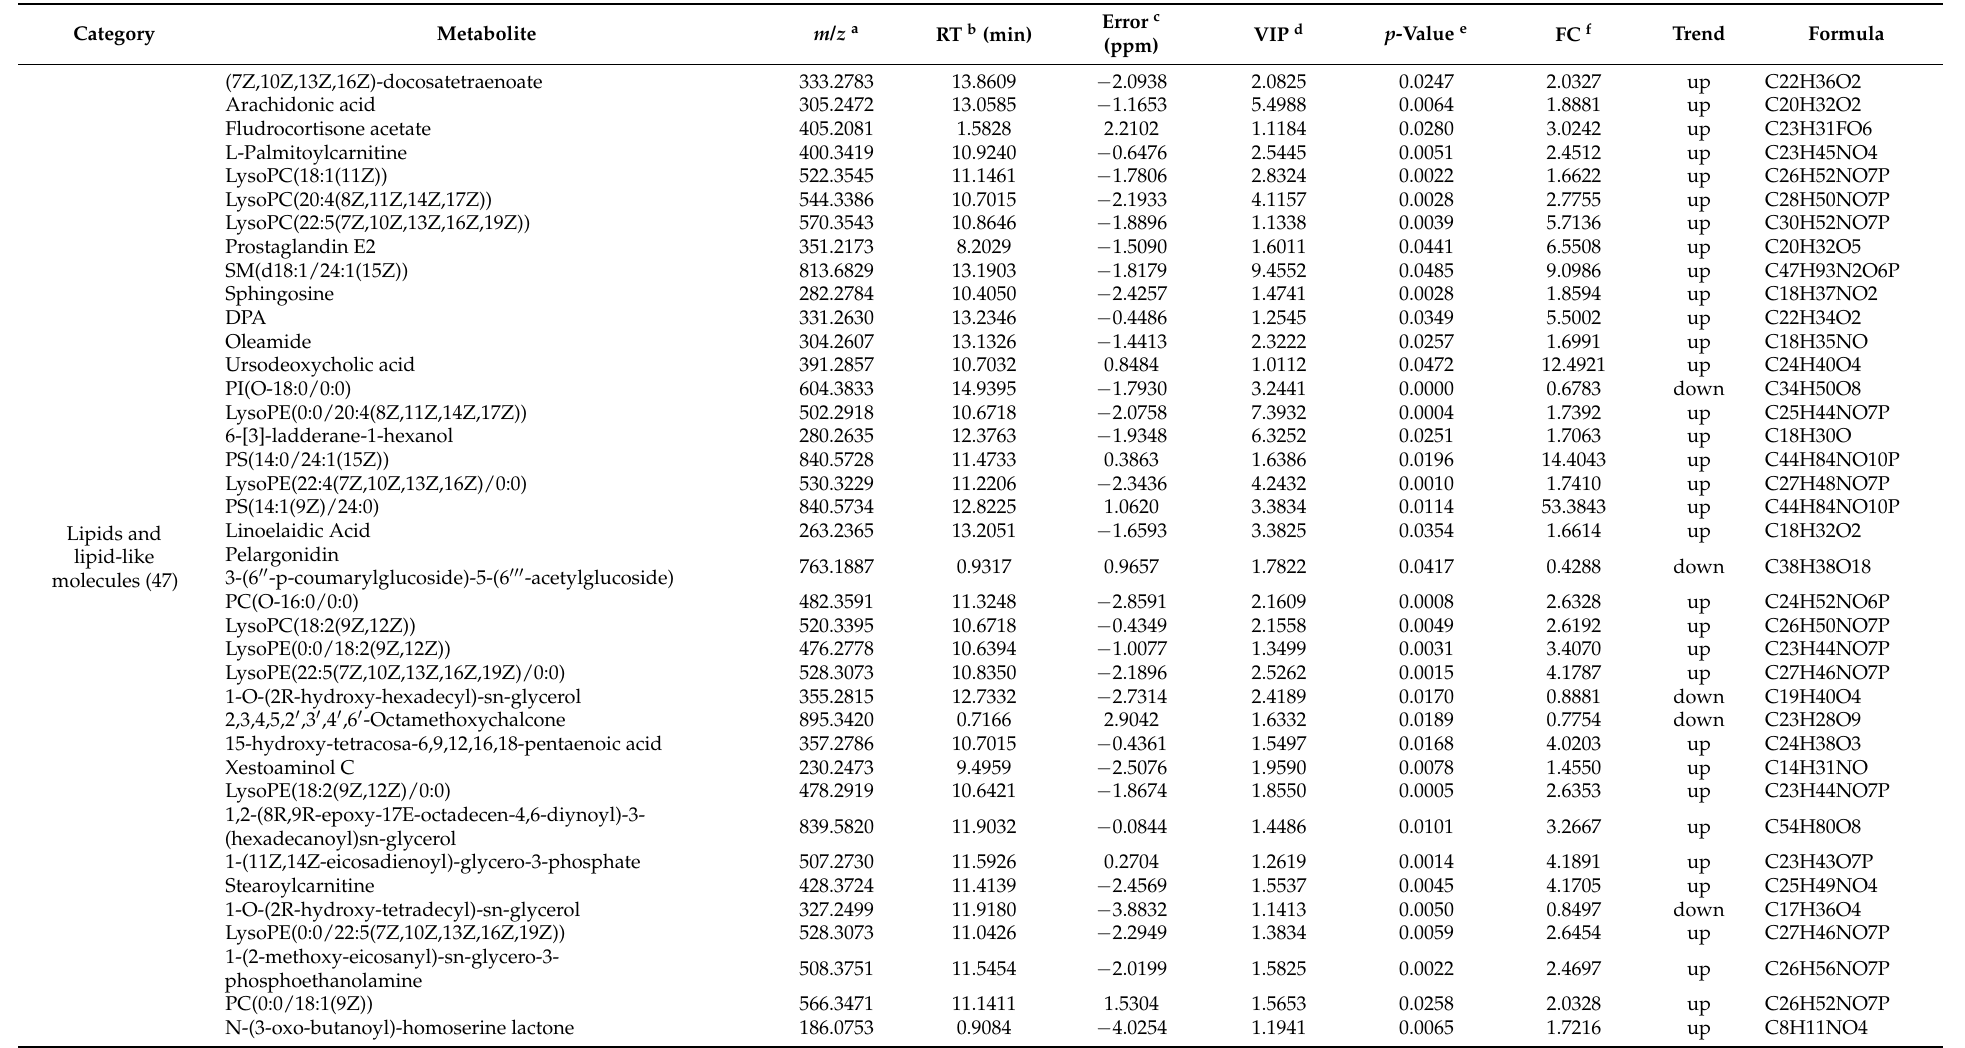
Table 2. The list of DEMs identified in the NOR and REG